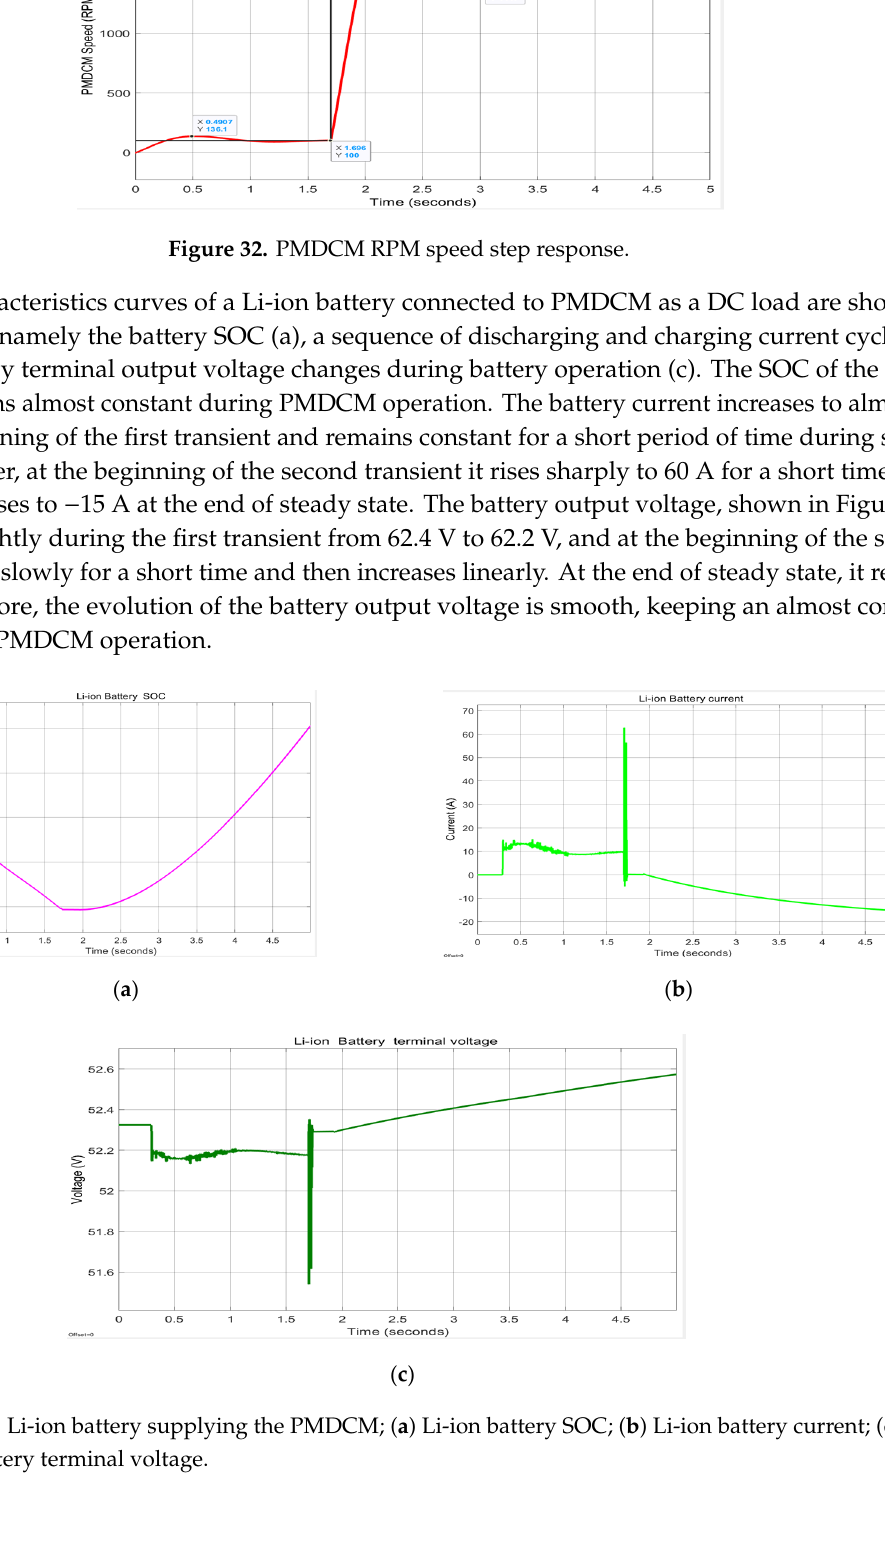
Figure 31. Closed-loop PMDCM-proportional-integral-derivative (PID) RPM speed control.